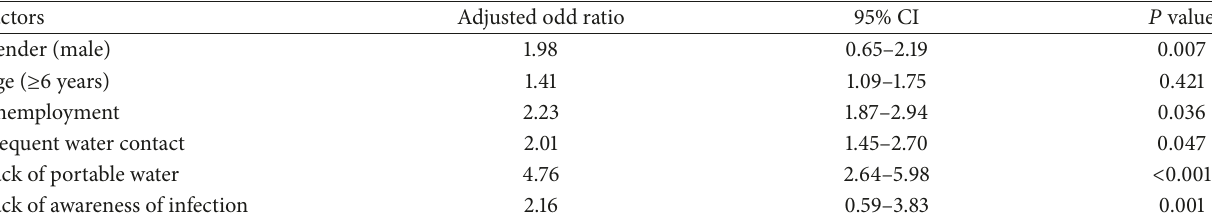
Table 5: Multivariate analysis of epidemiological factors of urinary schistosomiasis among the infected